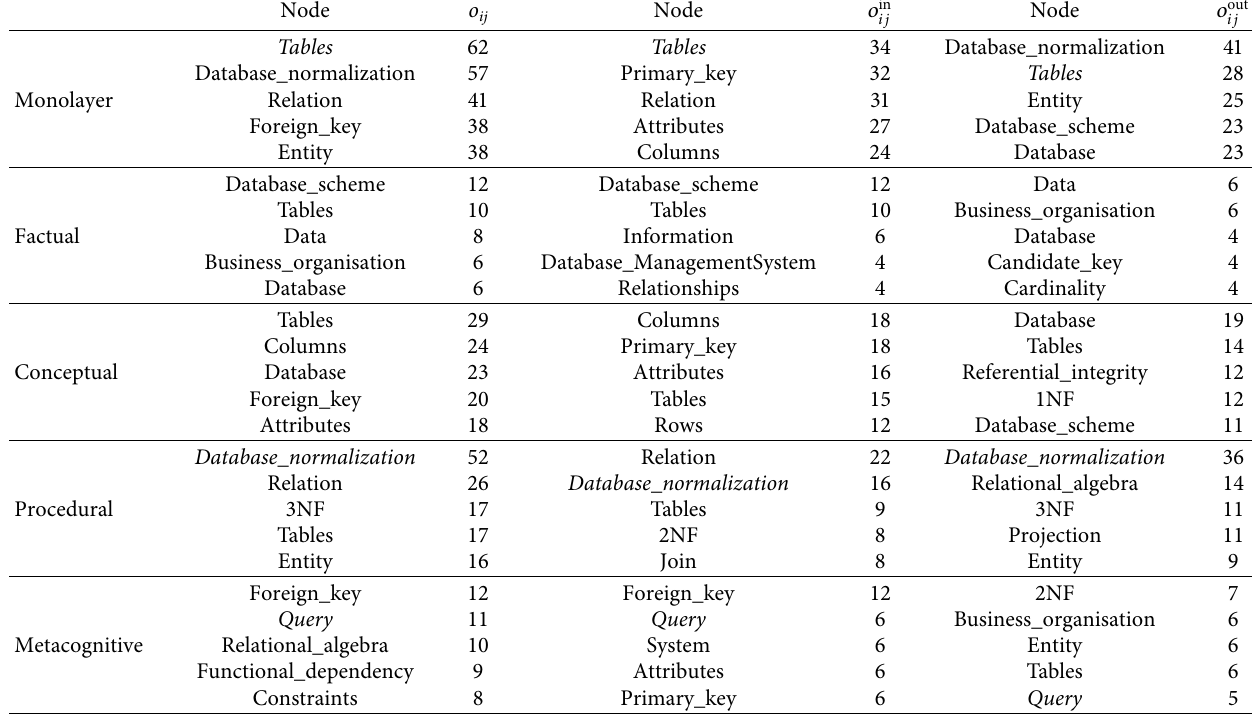
Table 3: Top five highly ranked nodes according to the weighted degree ( o weighted monolayer network.